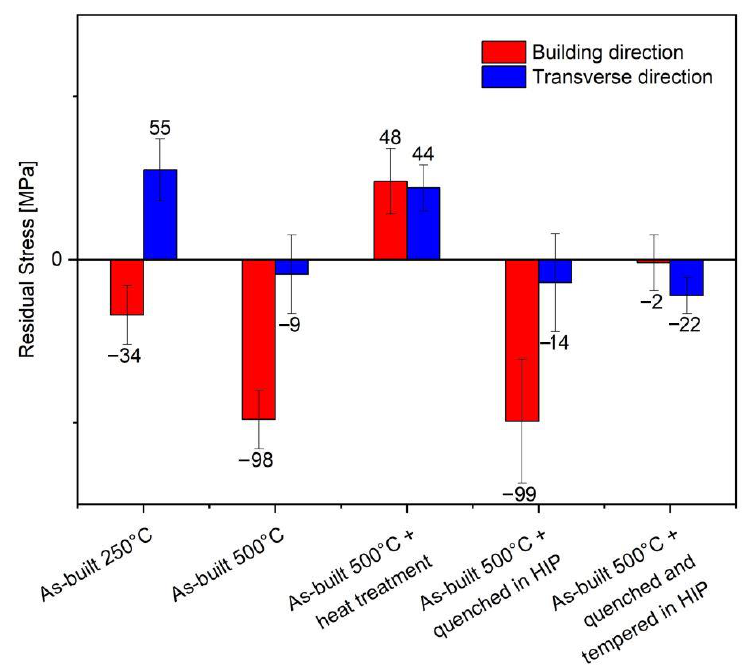
Figure 12. Residual stresses in different conditions.